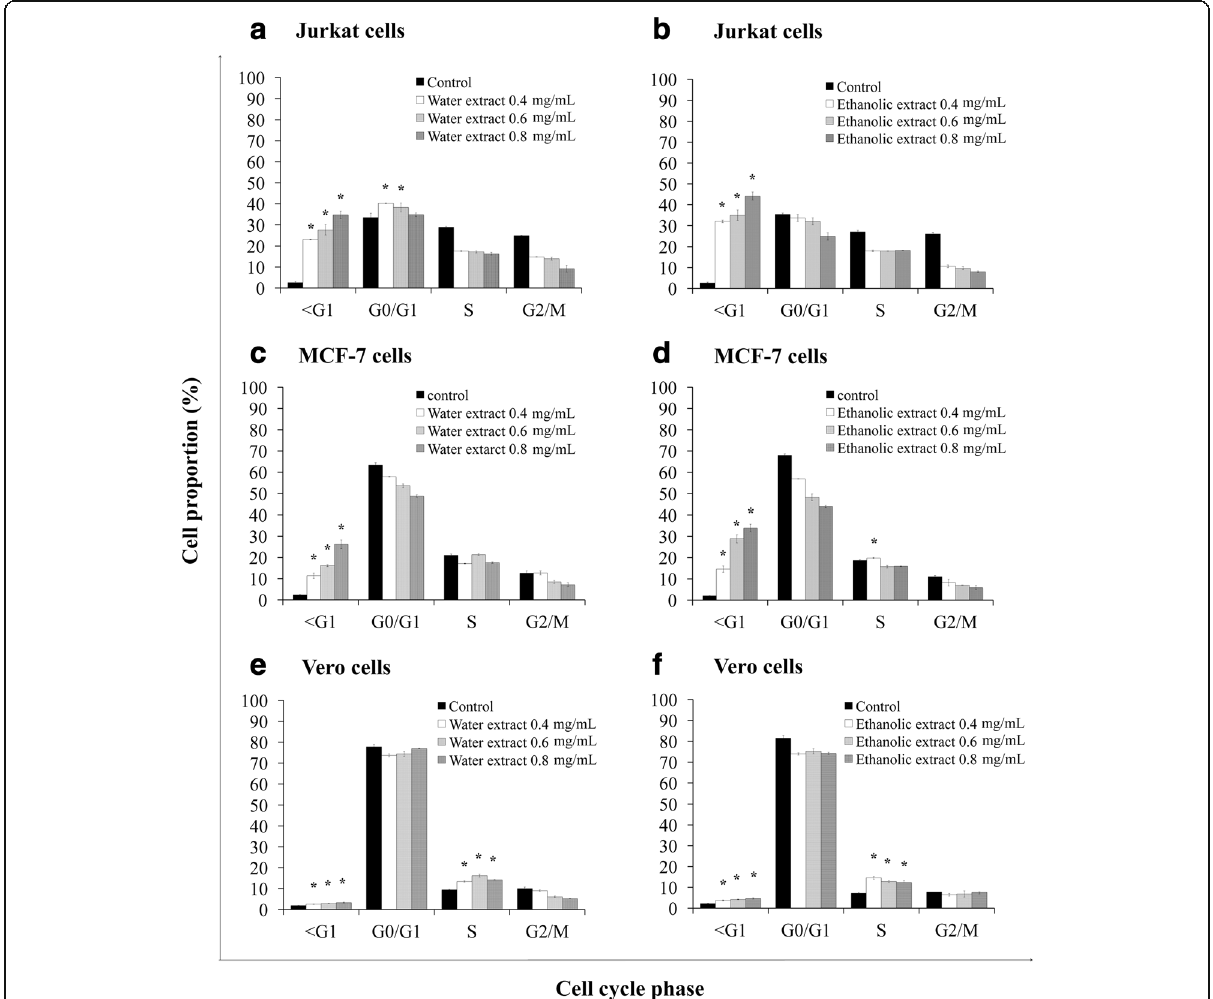
Fig. 6 Effects of water and ethanolic extracts prepared from the powdered formula of H. cordata fermented broth and P. emblica fruit on cell cycle progression were analyzed by flow cytometry after the cells were stained with propidium iodide. For cell cycle analysis, Jurkat ( a , b ), MCF7 ( c , d ) and Vero ( e , f ) cells were treated with or without (control) the extracts for 24 h. Cell numbers are presented as a percentage of the total analyzed cells. Each value is presented as mean ± SD from three independent